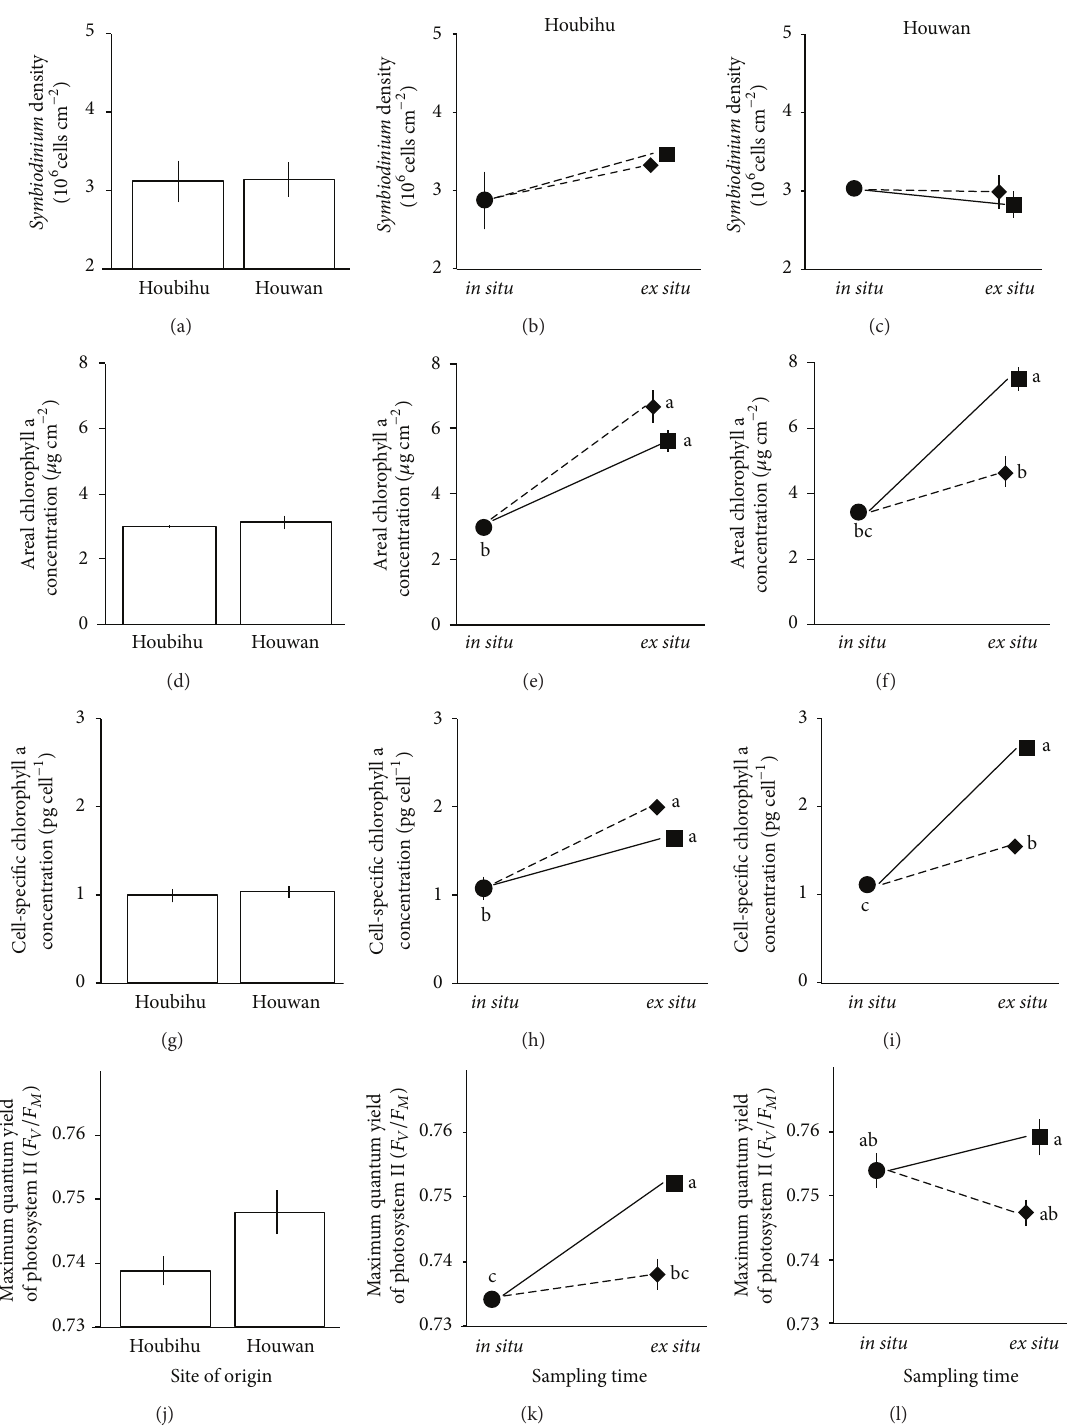
Figure 2: In situ versus ex situ physiology. Biopsies were removed from each of six Seriatopora hystrix colonies collected from the upwelling (Houbihu) and nonupwelling (Houwan) sites and analyzed for Symbiodinium density ((a)–(c)), areal chlorophyll a (chl -a ) concentration ((d)– (f)), cell-specific chl -a concentration ((g)–(i)), and maximum dark-adapted quantum yield of photosystem II ( 𝐹 𝑉 /𝐹 𝑀 ; (j)–(l)) as described in the text. Comparisons between sites of origin in situ are shown in (a), (d), (g), and (j), while comparisons over time ( in situ versus ex situ ) are shown across both temperature treatments (stable (black circles connected to black squares with straight lines) and variable (black circles connected to black diamonds by dotted lines)) for Houbihu ((b), (e), (h), and (k)) and Houwan ((c), (f), (i), and (l)). In all panels, error bars represent standard error of the mean. Tukey’s honestly significant difference groups in (e), (f), (h), (i), (k), and (l) represent significant differences ( 𝑃 < 0.05 ) in response to the interaction of sampling time and temperature